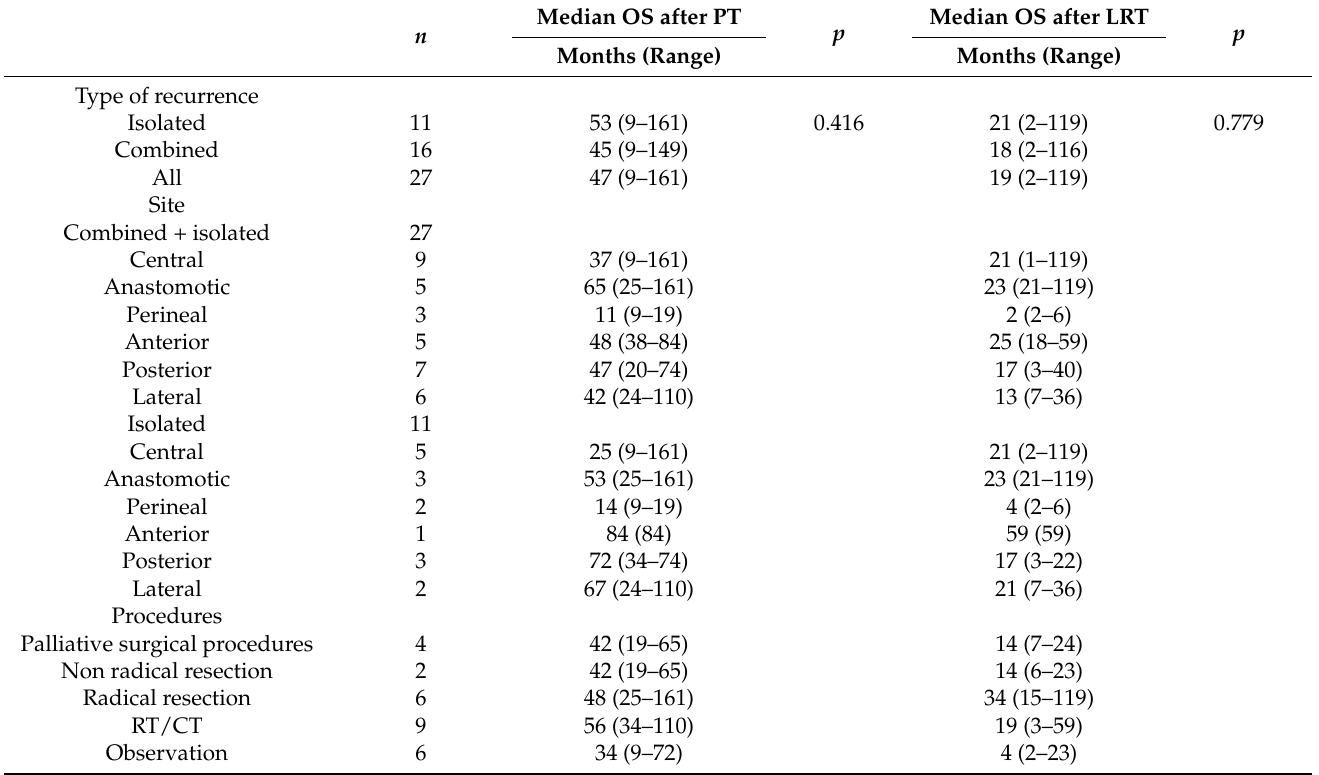
Table 5. Overall survival in patients with local recurrence according to treatment procedures, type of recurrence and